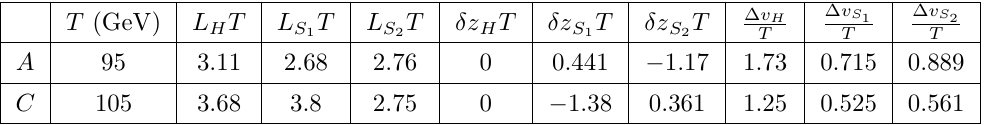
Table 6. EWPT Temperature and rescaled VEV-profile parameters for eq. (4.10). The parameters for benchmarks B and D are approximately equivalent to those of A and C ,